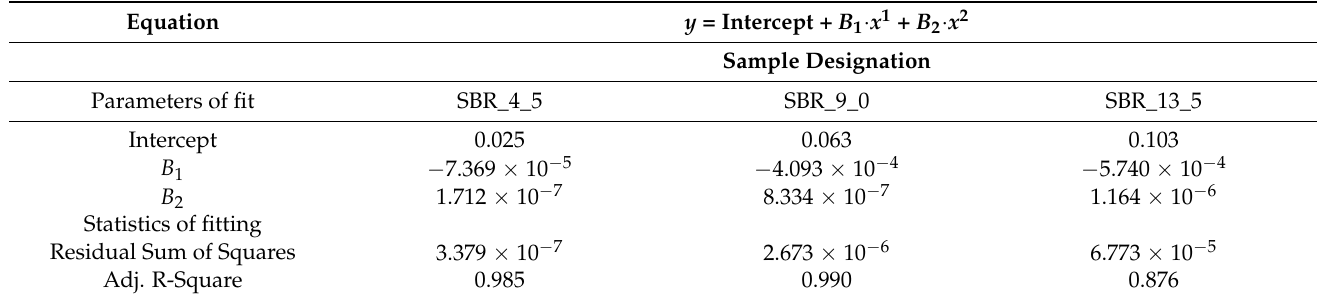
Table 4. Parameters for the parametric fitting of curves in Figure 8.